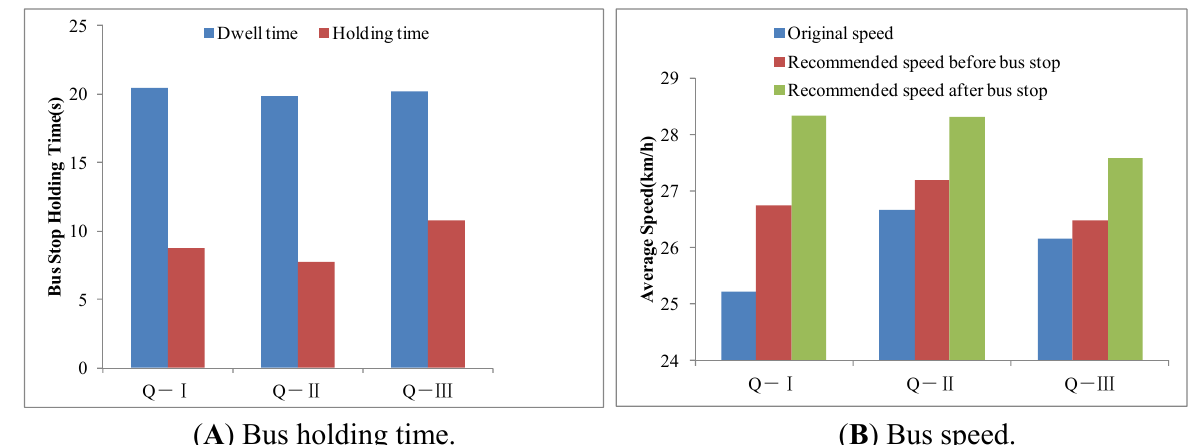
Figure 4. Average recommended holding time and bus speed.